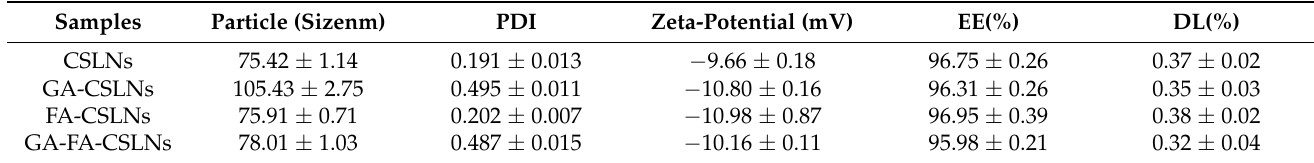
Table 1. Characteristics of CSLNs (x ± s, n = 3).